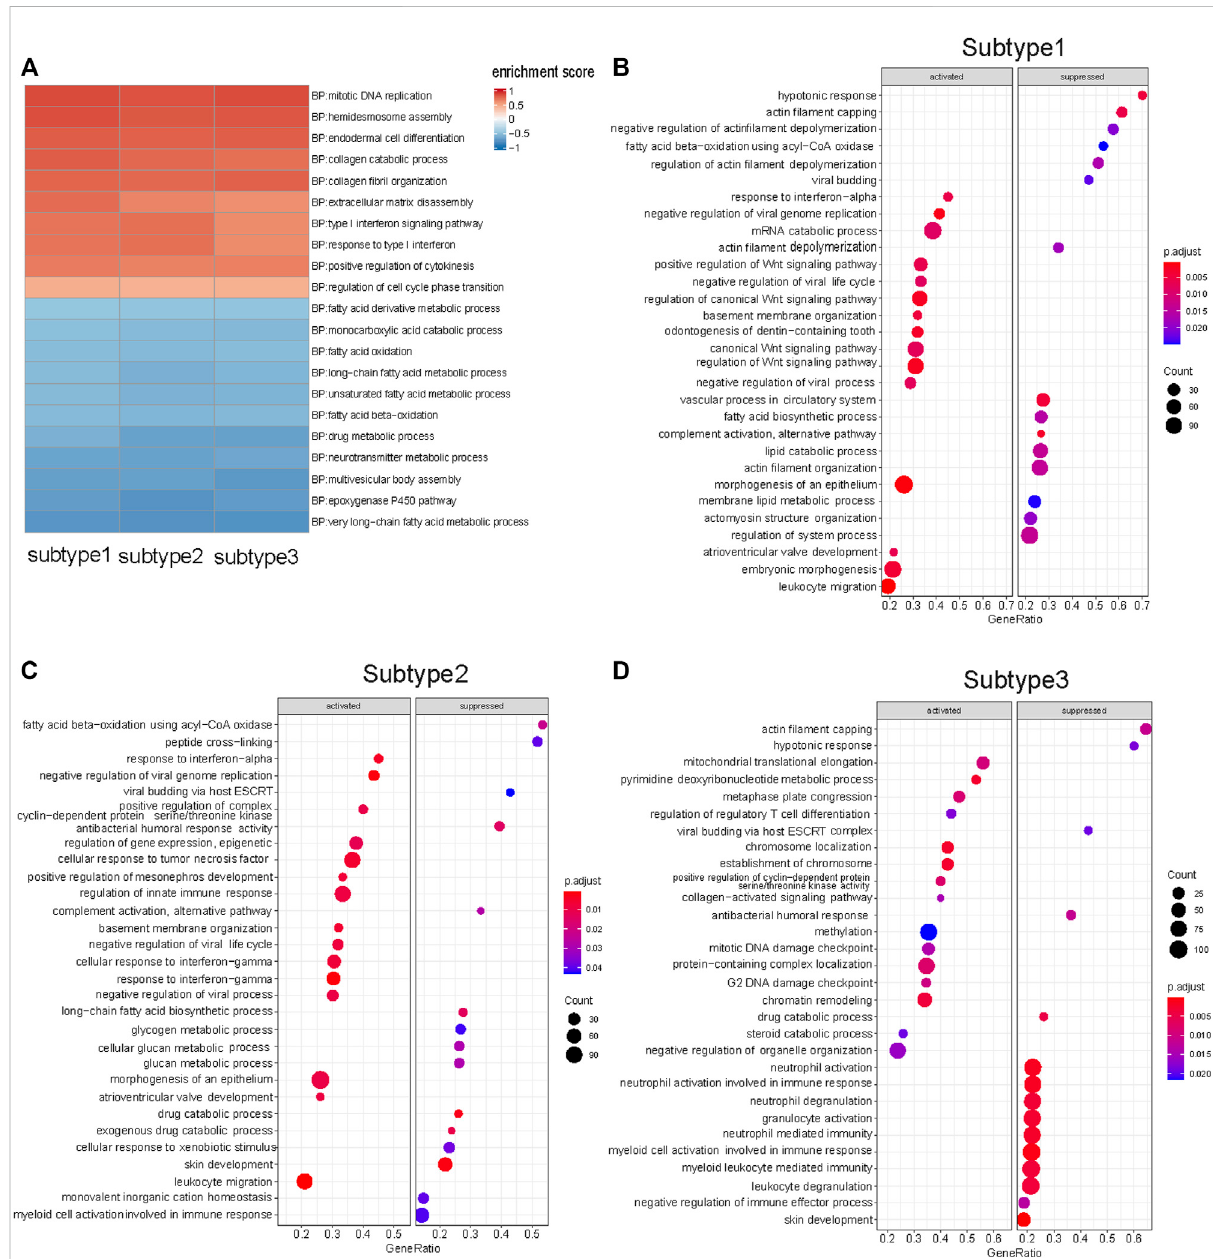
FIGURE 3 GSEA results of three subtypes. (A) Ten up-regulated and ten down-regulated biological pathways were selected from the shared enriched pathways in three subtypes tumor samples. (B) Top 15 biological pathways that speci fi c up- and down-regulated in Subtype 1 tumor samples. Wnt signaling pathway was signi fi cantly up-regulated in Subtype 1. (C) Top 15 biological pathways that speci fi c up- and down-regulated in Subtype 2 tumor samples. Glycogen metabolism biological pathway was signi fi cantly down-regulated in Subtype 2. (D) Top 15 biological pathways that speci fi c up- and down-regulated in Subtype 3 tumor samples. Neutrophil-mediated immunological pathways were down-regulated in Subtype 3. (FDR <